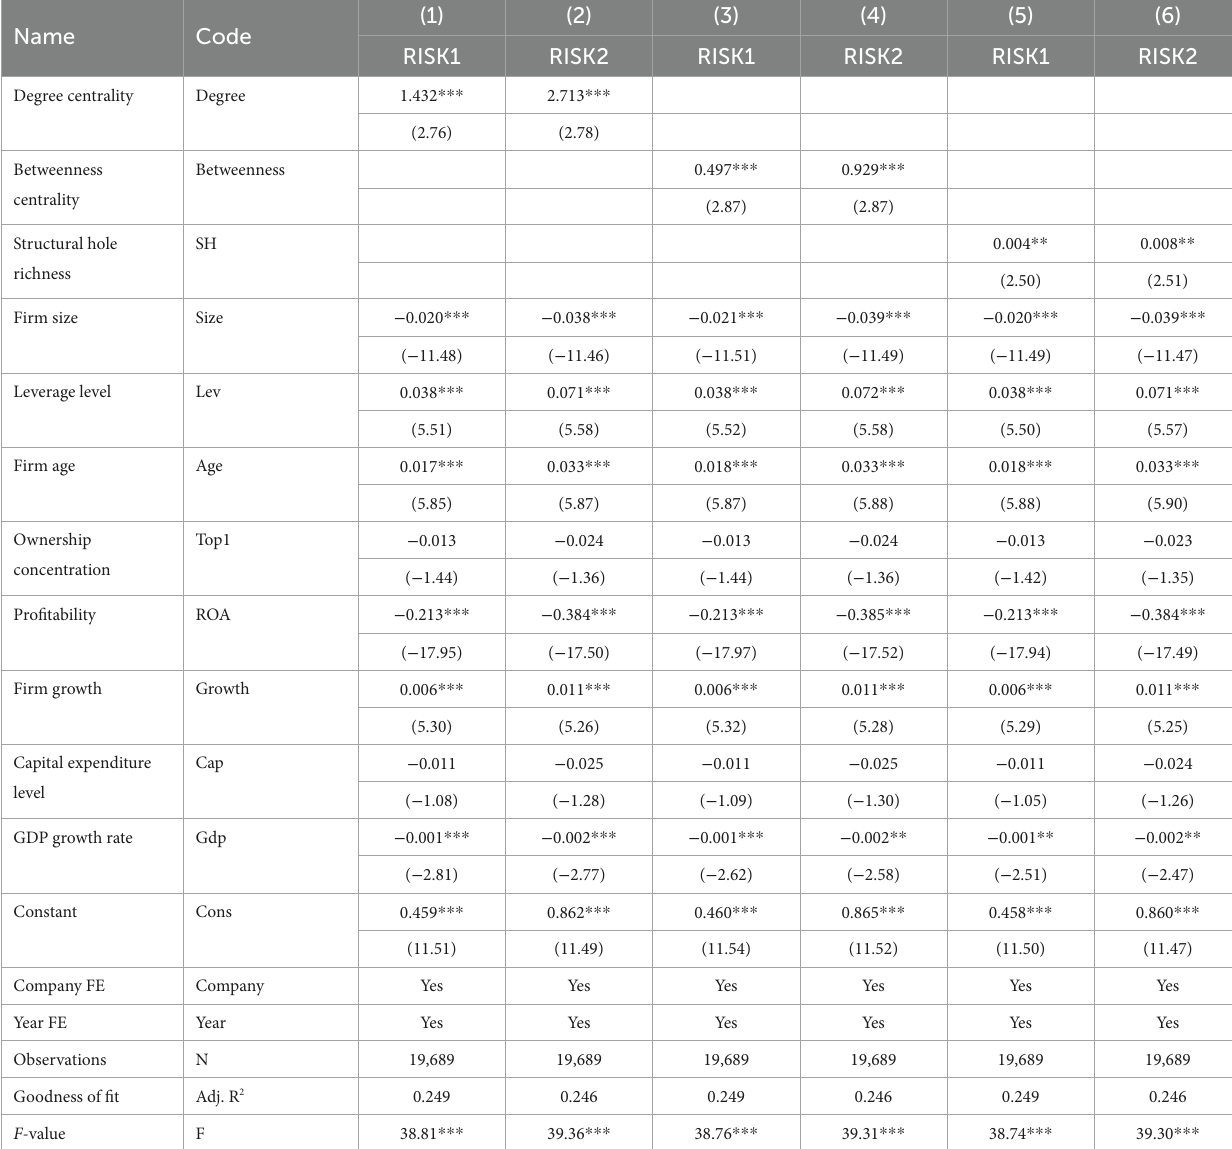
TABLE 4 Interlocking director network and corporate